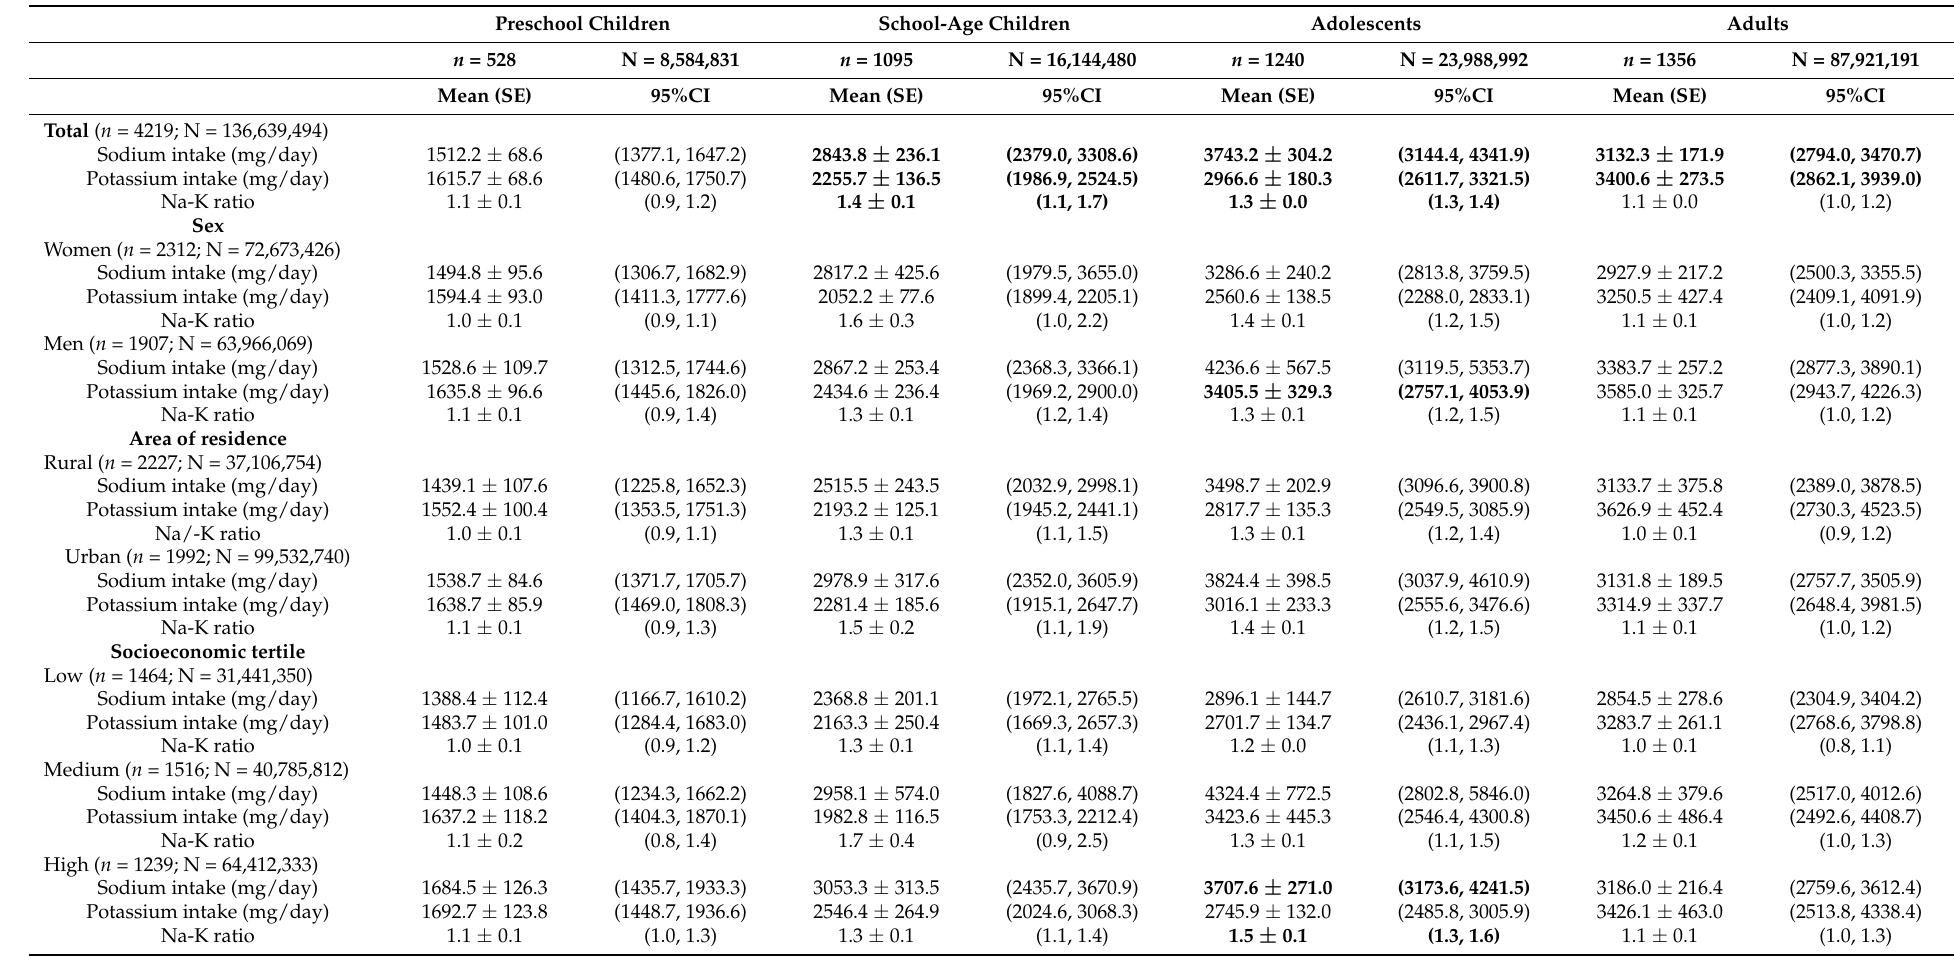
Table 1. Sodium and potassium mean intake by age group according to sociodemographic characteristics and Body Mass Index in Mexican population. ENSANUT